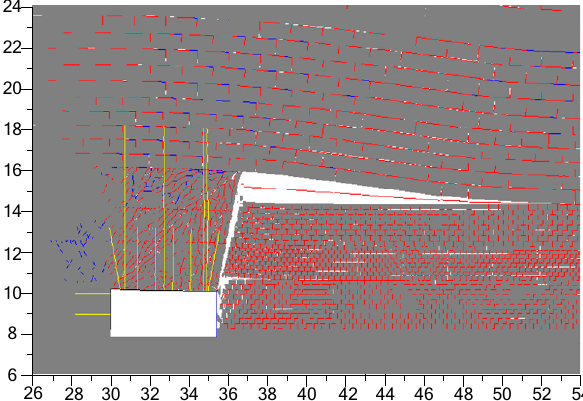
Figure 13. Simulated microscopic crack evolution in the entry-surrounding rock in a supported condition.